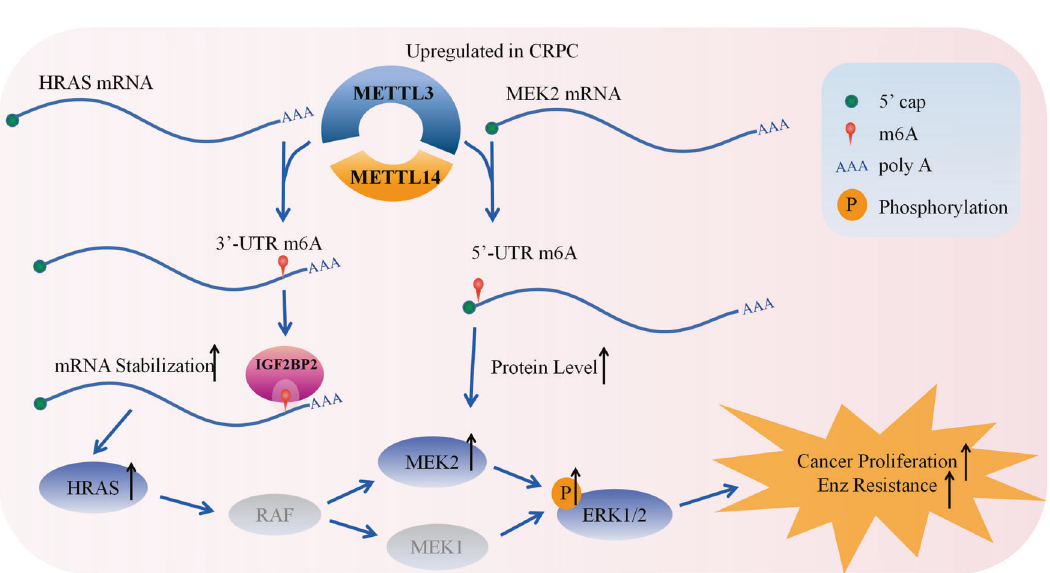
Fig. 8 Schematic describing how the upregulated METTL3&14 in CRPC activated the ERK pathway by regulating protein levels of HRAS and MEK2. METTL3 enhances RNA stability of HRAS and enhances protein translation of MEK2 to activate the ERK